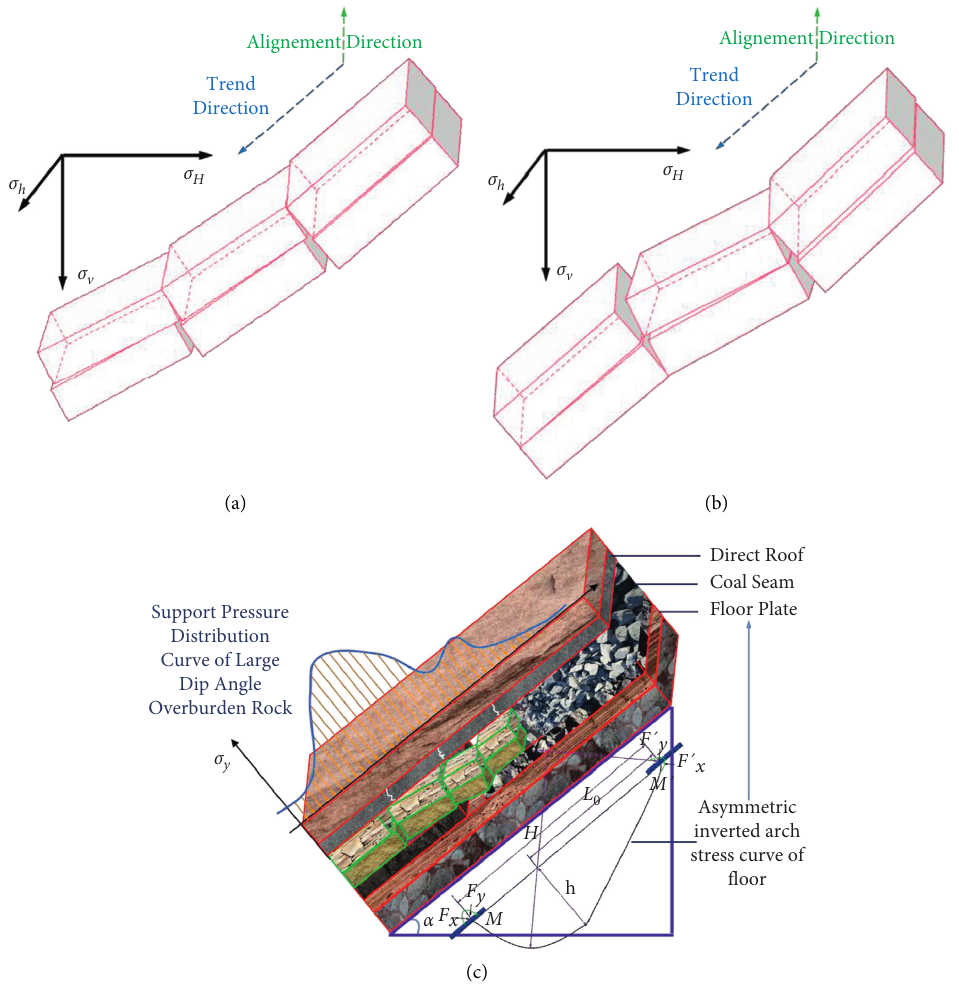
Figure 1: Stress characteristics of asymmetric inverted arch surrounding rock in stope. (a) Tendency accumulation structure formed by rock migration. (b) Anti-tendency accumulation structure formed by rock migration. (c) Asymmetric distribution mechanical model of abutment pressure in steeply dipping coal seam